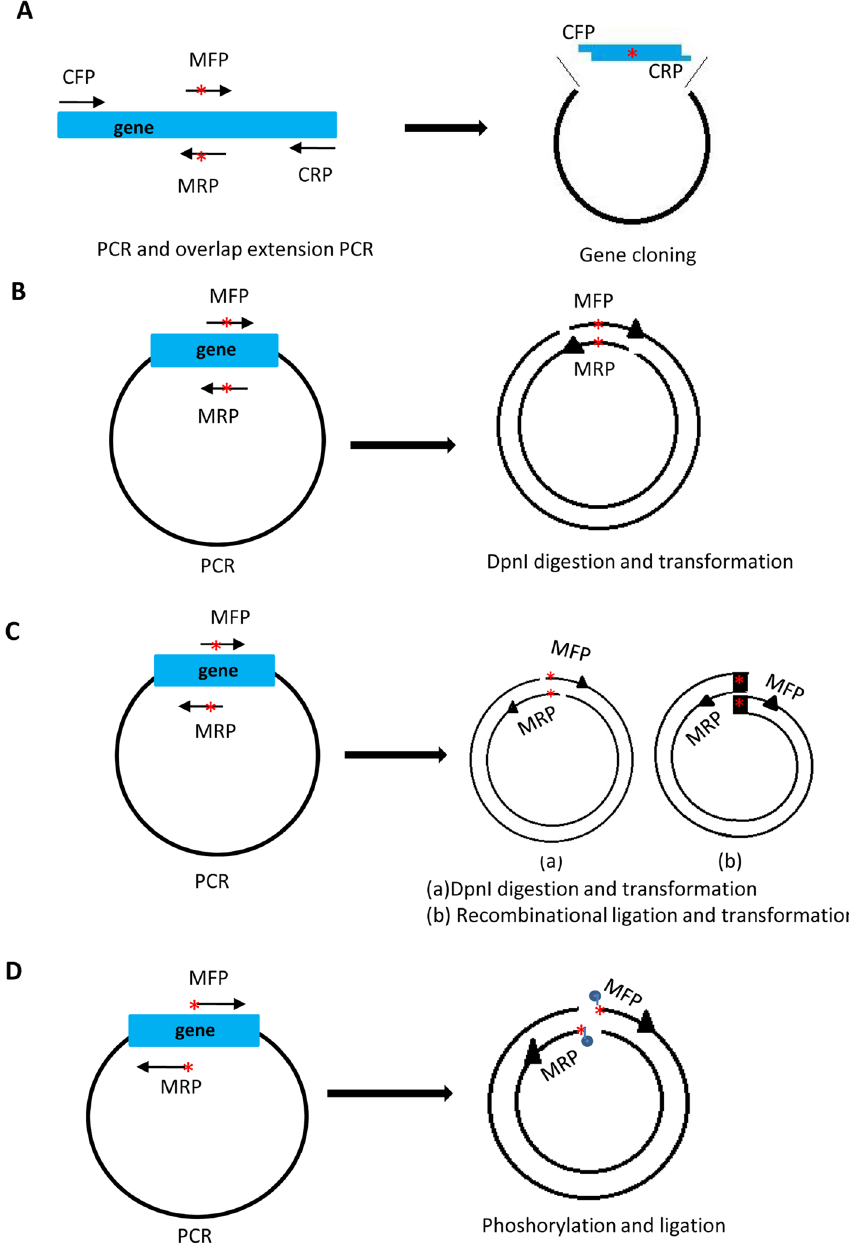
Figure 1. A summary showing the methods established for PCR-based site-directed mutagenesis. ( A ) A diagram for site-directed mutagenesis based on PCR, overlap extension PCR, and gene cloning. In this method, two PCR reactions are first performed with the primer pair of CFP and MRP and the primer pair of MFP and CRP. PCR products are purified and the resulting PCR products were used for overlap extension PCR with the primer pair of CFP and CRP. The products from overlap extension PCR were digested with restriction enzymes, and the resulting fragments were ligated with the plasmids digested with the same restriction enzymes. CFP, cloning forward primer; CRP, cloning reverse primer; MFP, mutation forward primer; MRP, mutation reverse primer. The red stars in the left and right panels represent mutated bases. ( B ) A diagram for site- directed mutagenesis based on PCR with a pair of complementary primers (double-strand DNA fragments), Dpn I digestion, and transformation. ( C ) A diagram for site-directed mutagenesis based on PCR with a pair of partially complementary primers, Dpn I digestion and transformation (a) or based on PCR with a pair of partially complementary DNA fragments, recombinational ligation, and transformation (b). ( D ) A diagram for site-directed mutagenesis based on PCR with a pair of inverse primers, phosphorylation, ligation, and transformation. The blue dots in the left panel represent phosphorylated groups. The red stars in A-D represent mutated